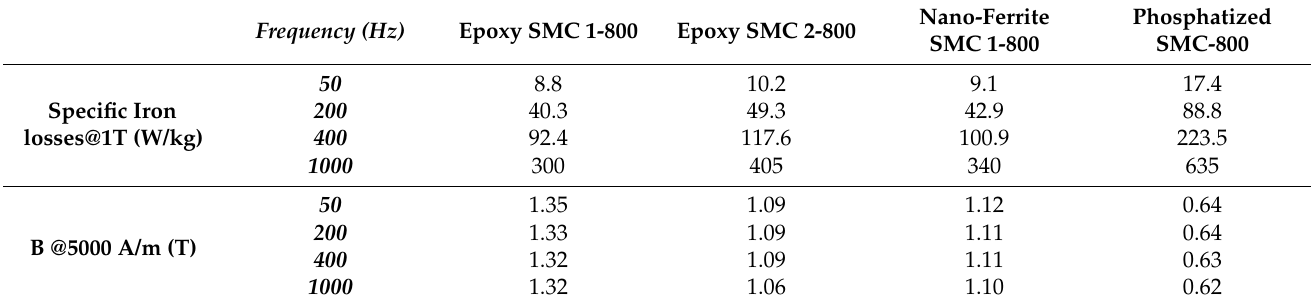
Table 1. The specific iron losses at 1 T and magnetic induction at 5000 A/m for produced toroid rings.